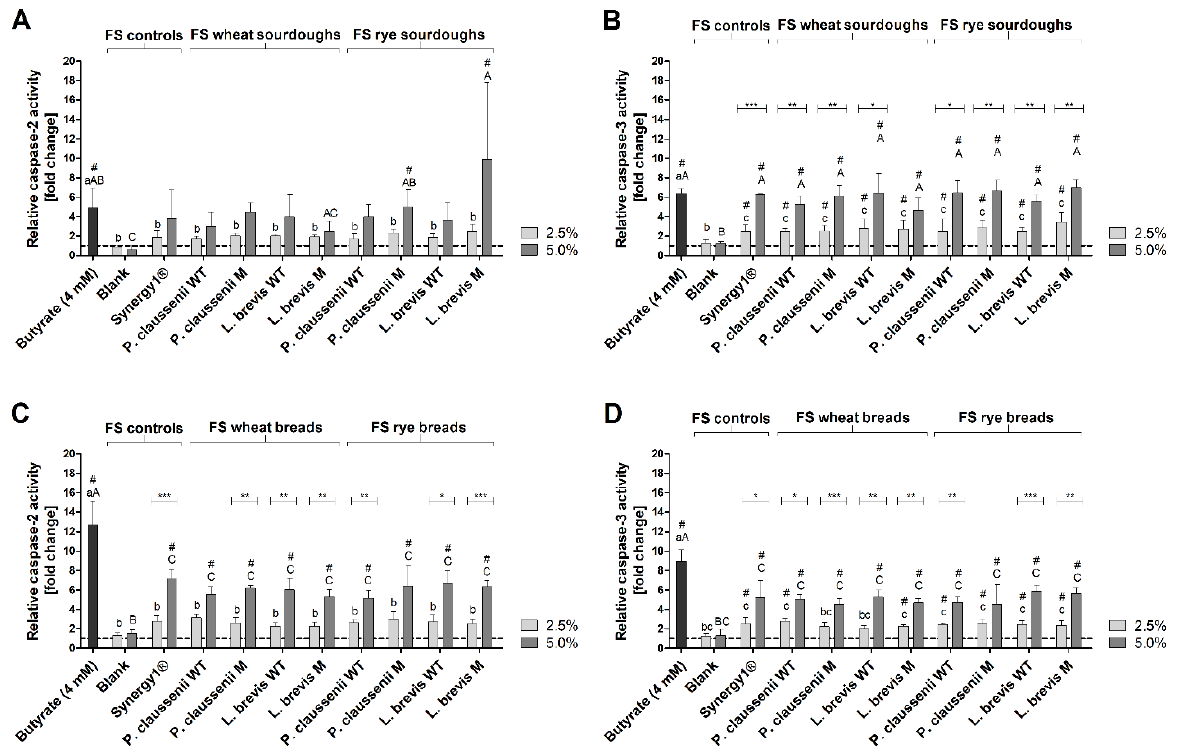
Figure 6. Relative activities of caspase-2 and caspase-3 in LT97 cells after treatment with 2.5% and 5% fermentation supernatant (FS) obtained from controls (blank, Synergy1 ® ) and wheat and rye sourdoughs ( A , B ) and with FS obtained from controls (blank, Synergy1 ® ) and wheat and rye breads ( C , D ) as well as 4 mM butyrate for 24 h (mean + SD, n = 3). Results are presented as fold changes based on a medium control, which was set 1 (dashed line). Sourdoughs and breads were generated using wild-type (WT) and mutant (M) strains of Pediococcus claussenii (WT: TMW 2.340, M: TMW 2.2123) and Levilactobacillus brevis (WT: TMW 1.2112, M: TMW 1.2320). Significant differences to the medium control ( # p < 0.05) and significant differences between cells treated with 2.5% FS as well as butyrate ( a–c p < 0.05) and 5% FS as well as butyrate ( A–C p < 0.05) were obtained by two-way ANOVA and F-test according to Ryan–Einot–Gabriel–Welsh. Different letters represent significantly different results. Significant differences between cells treated with 2.5% and 5% FS were obtained by unpaired Student’s t -test (* p < 0.05, ** p < 0.01, *** p < 0.001). TMW: Technische Mikrobiologie Weihenstephan.